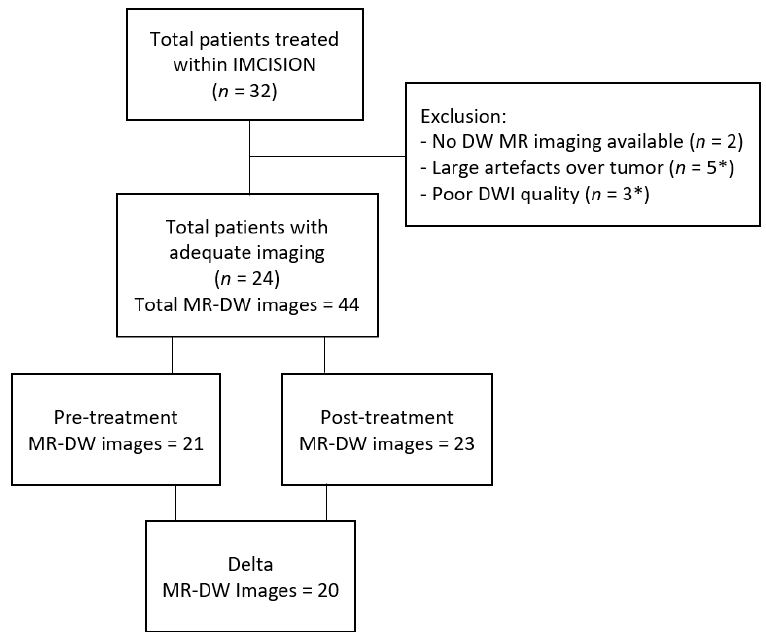
Figure 2. Flow diagram of the patient inclusion. MR-DW: magnetic resonance diffusion weighted, *: Some patients had both a large artefact and low DWI quality. Table 1. HPV: human papillomavirus, OSCC: oropharyngeal squamous cell carcinoma, n : sample size, n : subsample size, AJCC: American Joint Committee on Cancer. NIVO MONO: nivolumab monotherapy, COMBO: combined nivolumab and ipilimumab.